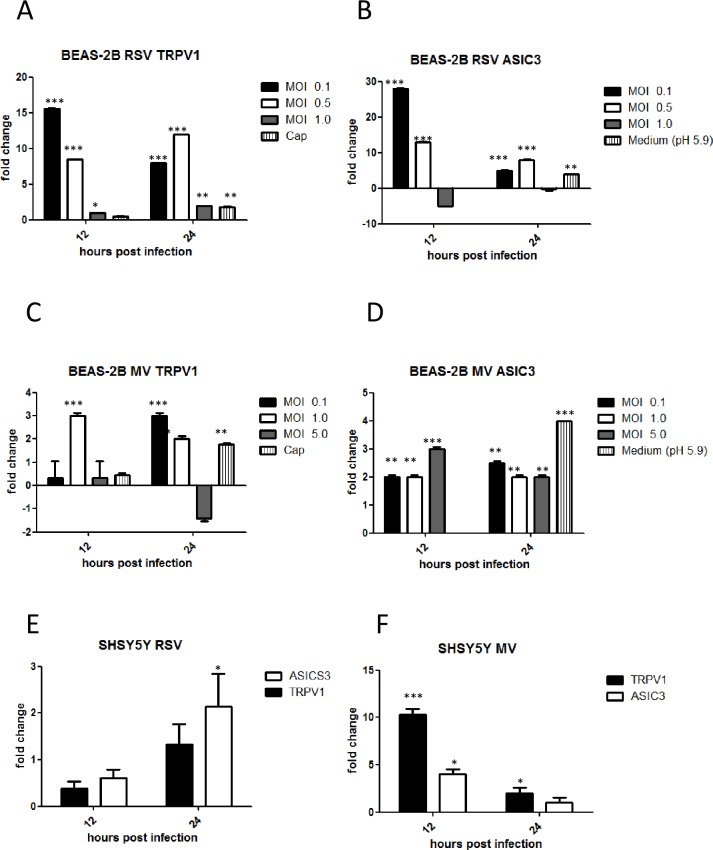
RSV and MV induced TRPV1 and ASIC3 mRNA up-regulation is dependent on virus titre and time post infection.BEAS-2B cells were infected at MOIs of 0.1, 0.5 and 1 (RSV) and 0.1, 1 and 5 (MV) for 12, 24 and 36 hours. Capsaicin (10μM) was used as positive control for stimulation of TRPV1 and acidified medium (pH 5.9) for stimulation of ASICS3. SHSY5Y were also infected with RSV (MOI 0.1) and MV (MOI 1) for 12 and 24 hours. TRPV1 and ASIC3 mRNA levels were determined by qRT-PCR. (A), (B) (C) and (D) BEAS-2 B cells; (E) and (F) SHSY5Y cells. (A) RSV TRPV1, (B) RSV ASCI3, (C) MV TRPV1, (D) MV ASICS3, (E) RSV and (F) MV. Data are presented as relative fold changes to TRPV1 and ASIC3 mRNA levels in uninfected/untreated control cultures.